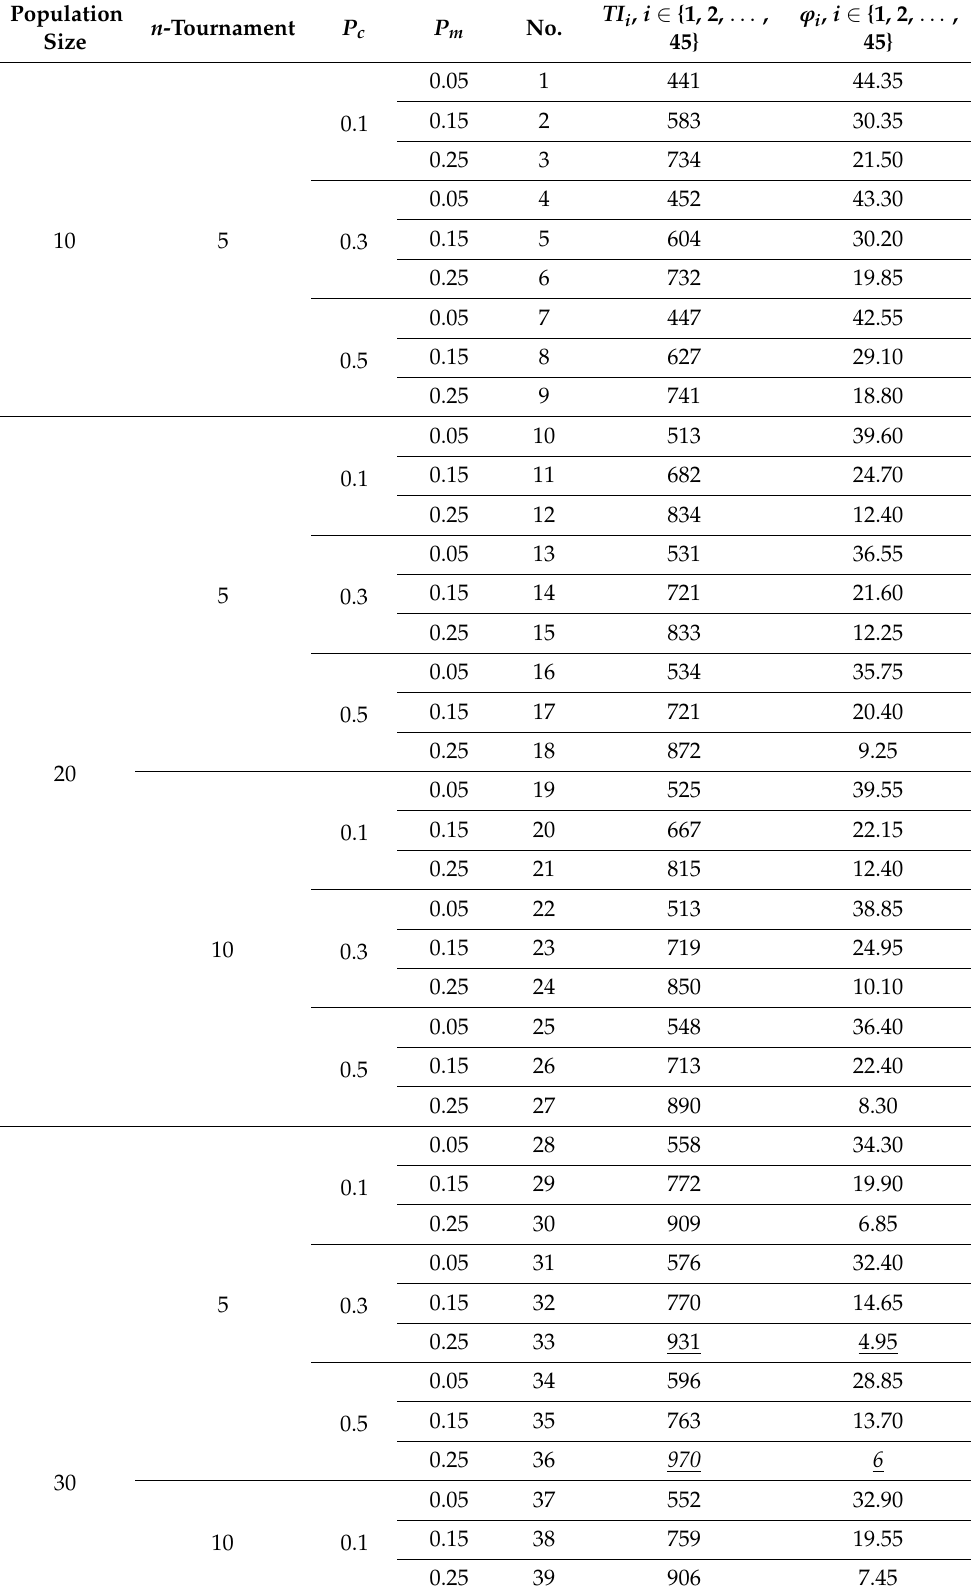
Table 2. Experimental results of the presented GA with different parameter